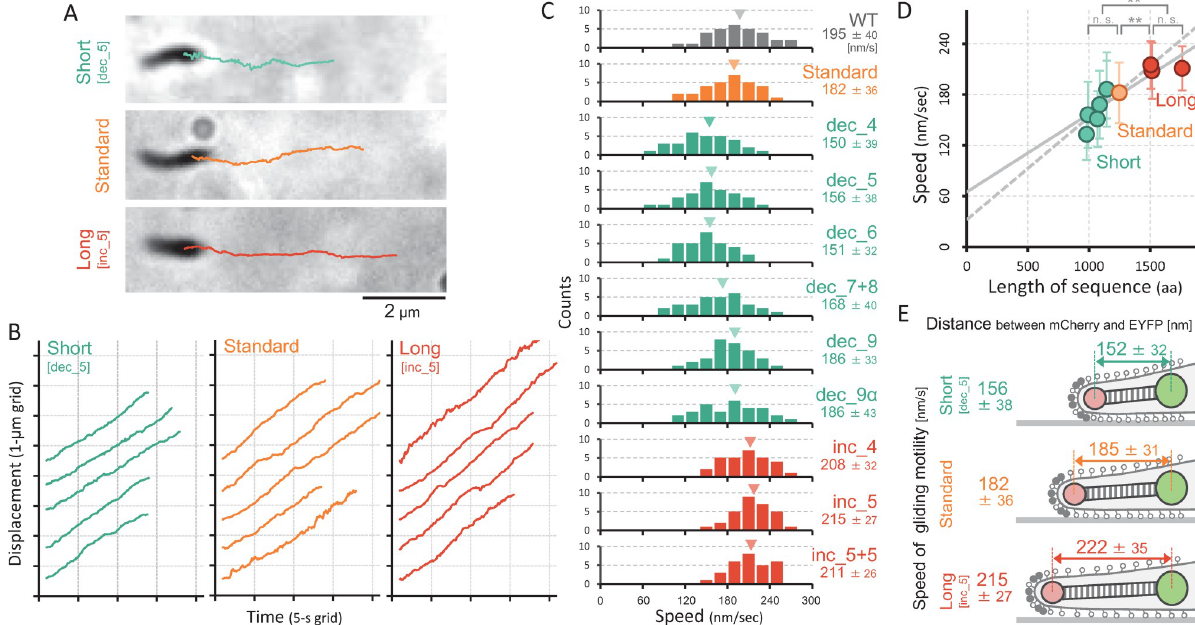
Fig 5. Gliding motility of the size-modified HMW2-derivative mutants. (A) Cell images and trajectories for 8.5 s. (B) Time course of the displacement of straightly moving cells. (C) Distribution of the gliding speed. The average and SD of 30 cells were presented in each panel. (D) Relationship between the gliding speed and the total amino acid sequence of coiled-coil domains in HMW2 derivatives. The average and SD in panel C were plotted. The solid and dashed lines showed the linear fit of all strains and the data excluding inc_5+5, respectively. Statistical analysis followed by t -test are shown; �� p 0.01, n. s. no significance. (E) Schematic illustration of the length-controlled attachment organelle and gliding speed.